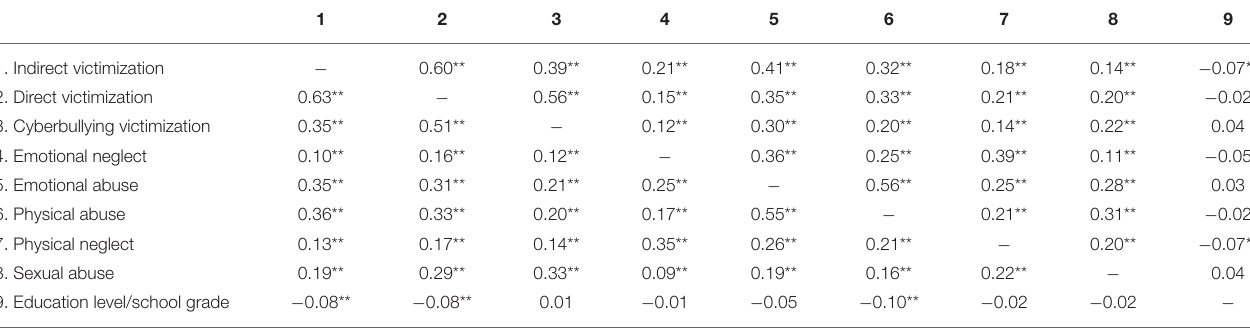
TABLE 2 | Correlations among the study variables for boys (below the diagonal, shaded in gray) and girls (above the diagonal). 1 2 3 4